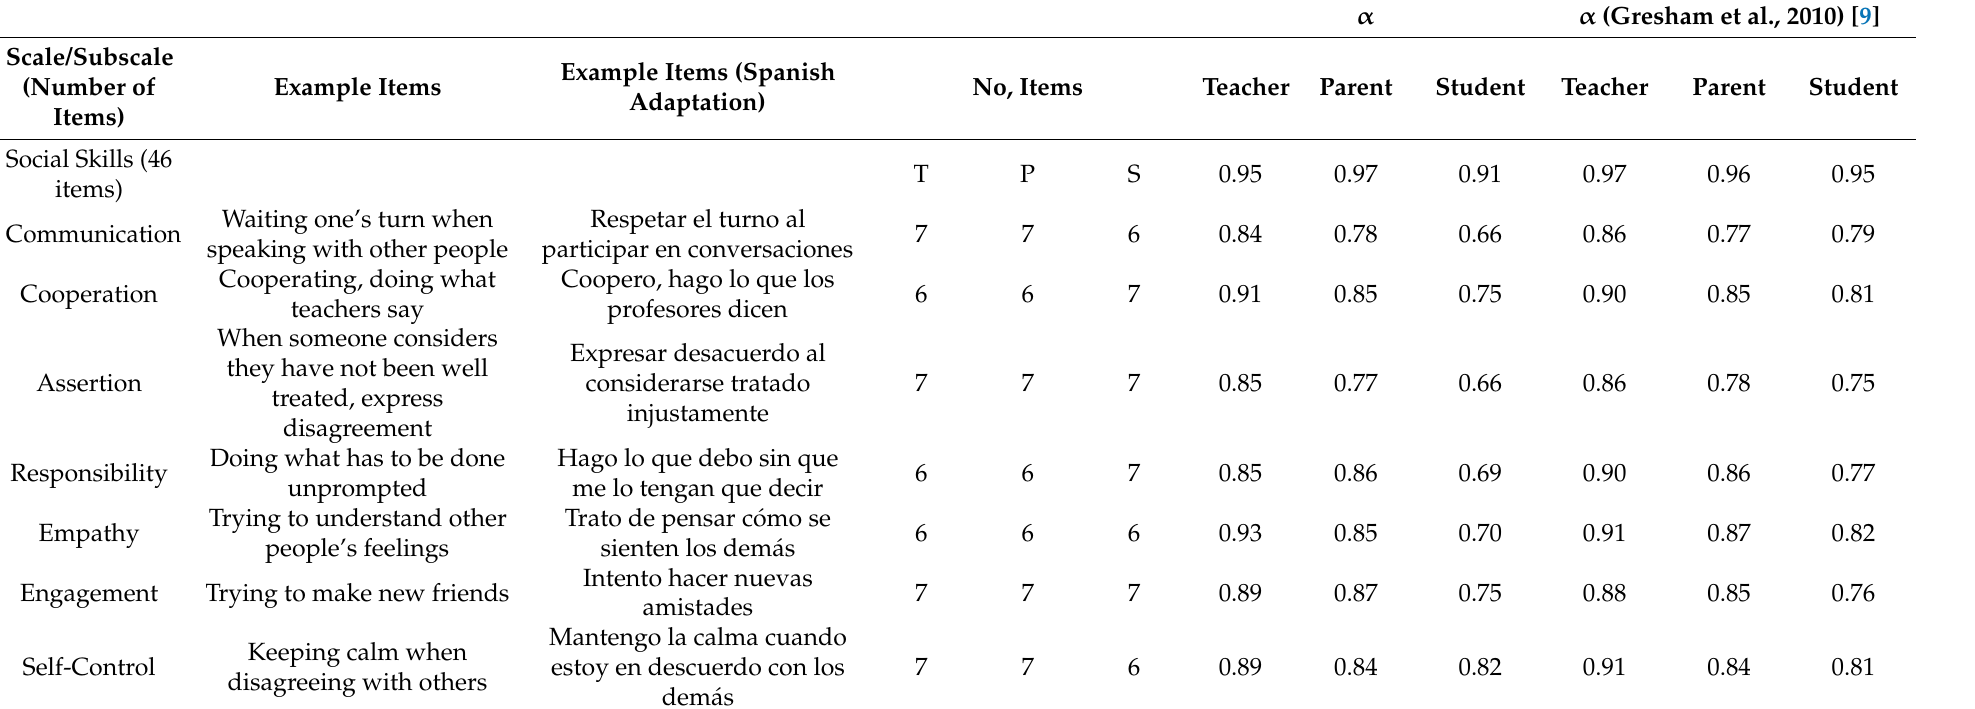
Table 2. Domains measured by the SESAS-SS along with sample items and reliability estimates.